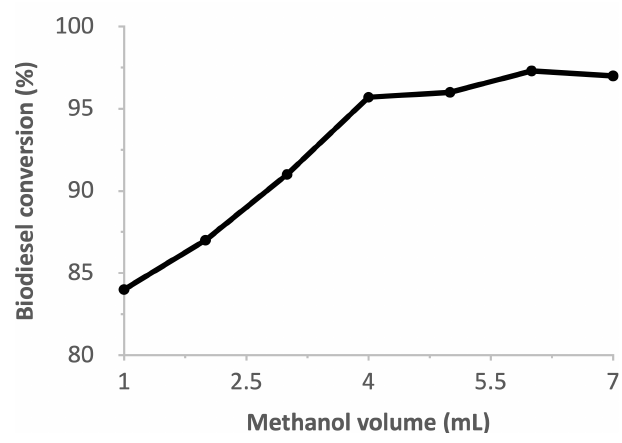
Figure 9. Effect of methanol volume on biodiesel conversion.